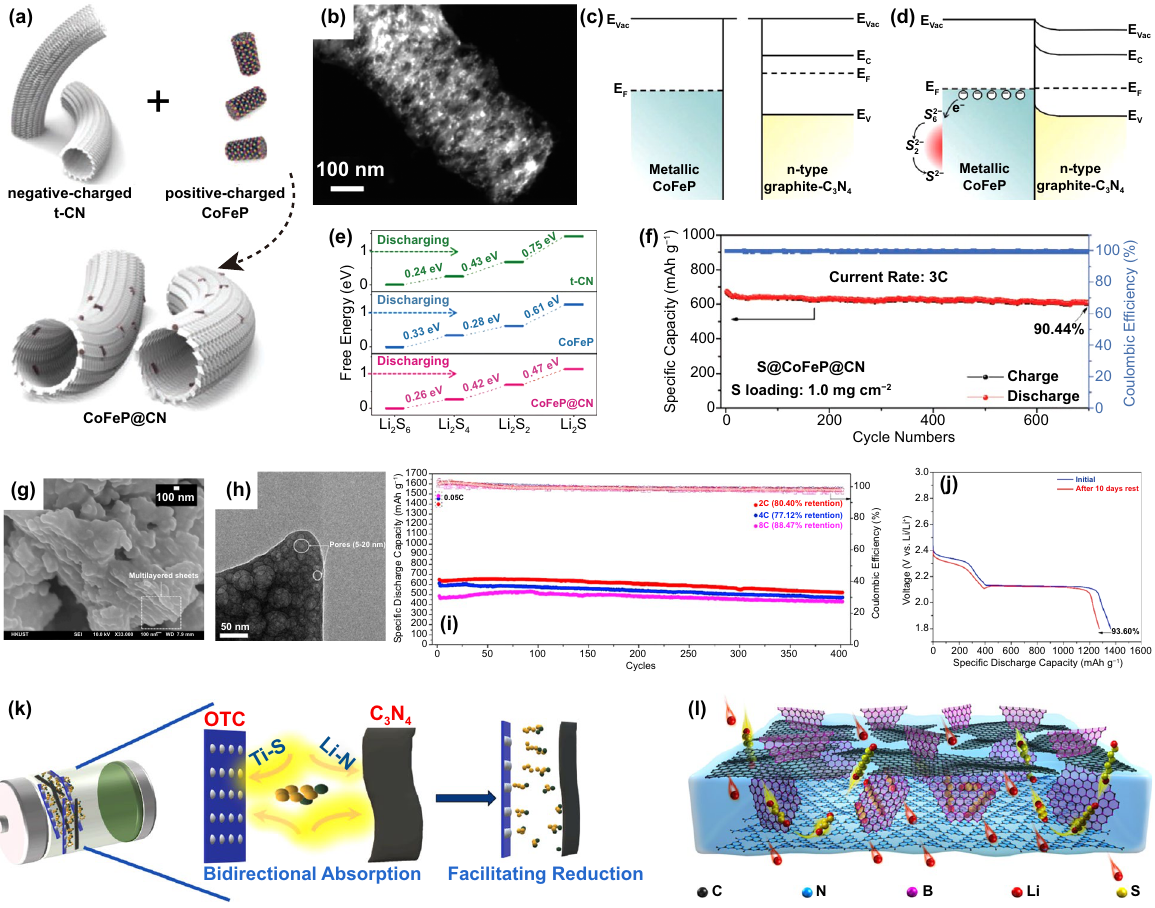
Fig. 9 a Schematic illustration of the preparation process of CoFeP@CN composite. b TEM image of CoFeP@CN. Energy band diagrams of CoFeP and g‑C 3 N 4 before c and after d Schottky contact formation. e Gibbs free energies of the reduction reactions of Li 2 S 6 , Li 2 S 4 , Li 2 S 2 and Li 2 S on t‑CN, CoFeP and CoFeP@CN, respectively. f Cycling performance of the cell with S@CoFeP@CN cathode at 3C [101]. Copyright 2021, Wiley–VCH. g SEM image and h HRTEM image of MoS 2 /g‑C 3 N 4 . i Cycling performance of the cell with MoS 2 /g‑C 3 N 4 /S cathode at 2C, 4C and 8C. j Discharge voltage profiles showing the self‑discharge behavior of MoS 2 /g‑C 3 N 4 /S cathode [59]. Copyright 2019, Elsevier. k Sche‑ matic illustration of interaction mechanism of OTC/C 3 N 4 and LiPSs [102]. Copyright 2021, Elsevier. l Schematic illustration of multifunctional ion‑sieve composed of g‑C 3 N 4 , BN, and graphene [52]. Copyright 2019, American Chemical